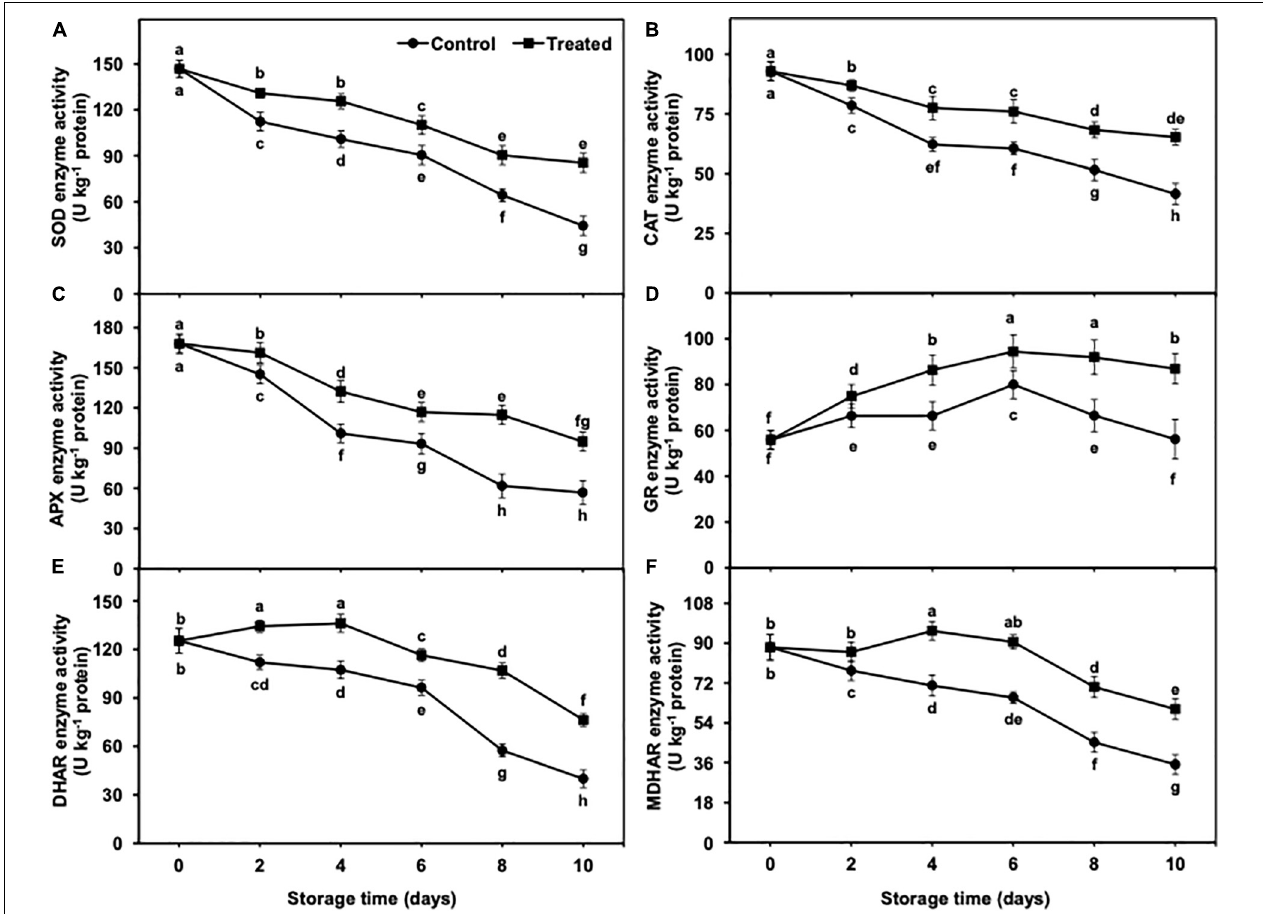
FIGURE 10 | Effect of hydrogen sulfide on SOD (A) , CAT (B) , APX (C) , GR (D) , DHAR (E) and MDHAR (F) enzymes activity in peel of banana fruit. Data are mean of three replications and vertical bars show standard of the means. Different letters show significant difference according to least significant difference